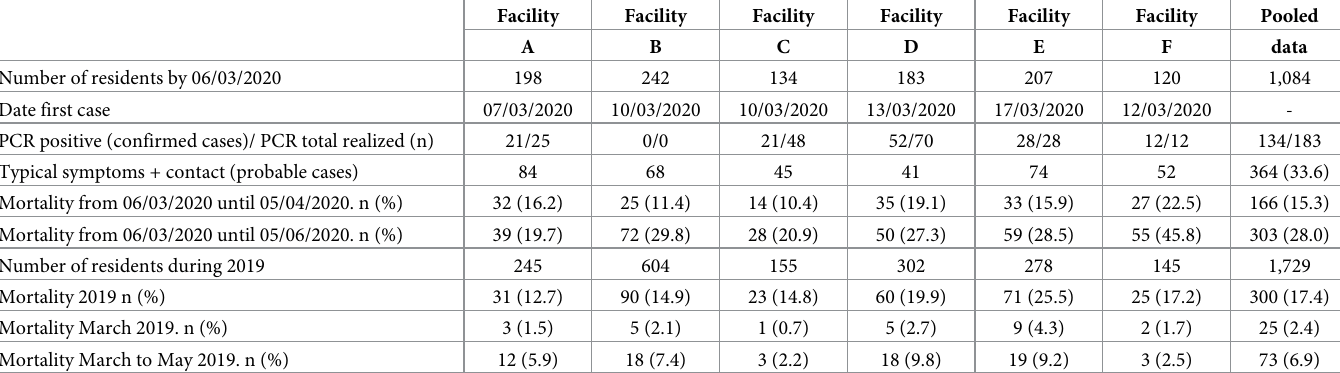
Table 1. Epidemiology of COVID-19 in six long-term care facilities in Albacete (Spain) between March 6 and April